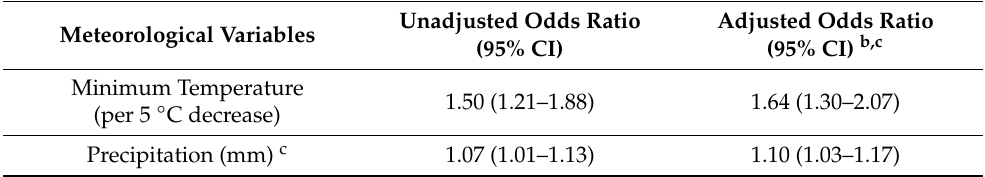
Table 2. The odds ratios for the association between a 5 ◦ C drop in the minimum daily temperature and hypothermic injury or death ( n = 97 events) a .